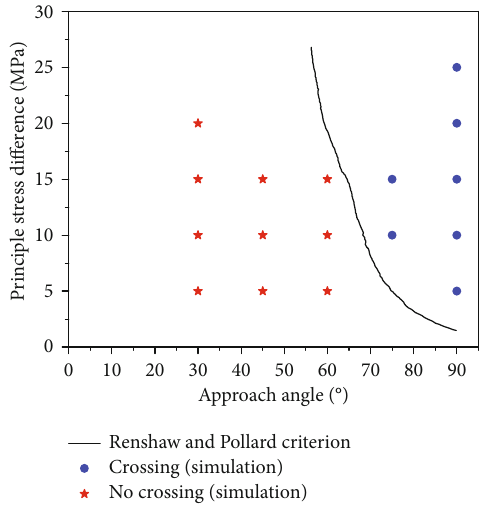
Figure 5: Comparison of numerical simulation and experimental